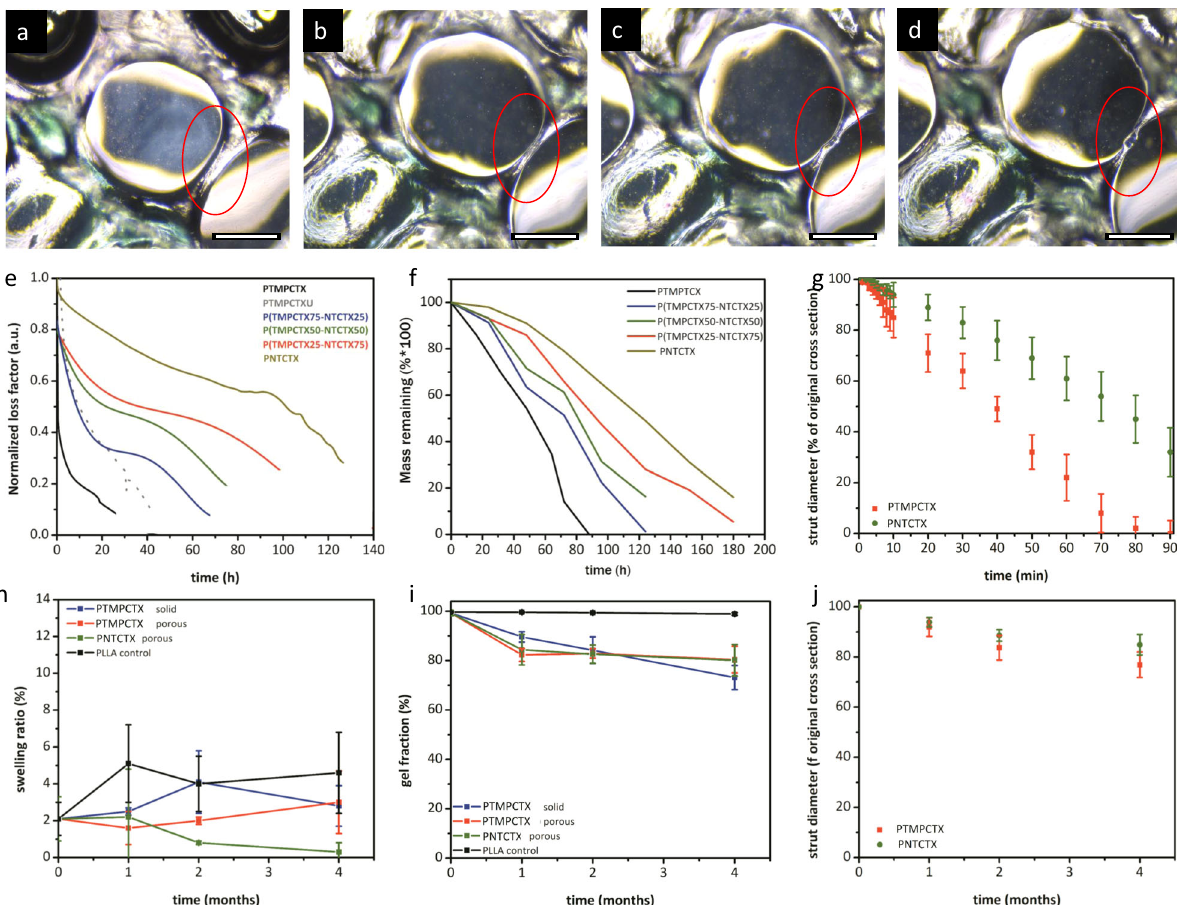
Fig. 6 Swelling and degradation behavior of 3D-printed materials. Representative microscopy images of a printed PTMPTCX scaffold immersed in 5 M NaOH over 15 min, demonstrating surface-erosion behavior of the denoted strut (red circle) immediately upon immersion in the solution ( a ), at 5 min ( b ), 10 min ( c ), and 15 min ( d ). Representative curves of uniaxial testing of polycarbonate-derived material fi lms immersed in 5 M hydrolytic degradation solution at 37 °C, with samples deformed 50 µ m at 1 Hz until failure ( e ) and corresponding static gravimetric degradation analysis at the same conditions ( f ), along with in vitro strut erosion measurements from microscopic analysis of printed scaffolds immersed in 5 M NaOH at 37 °C ( g ). Post-implantation assessment of sample swelling ( h ) and gel fraction ( i ) were used to assess the extent and type of degradation of the samples after removal from tissue at discrete timepoints, with accompanying measurements of strut diameters from printed scaffolds ex vivo ( j ). Scale bar = 200 µ m. Data are presented as mean values with error bars = standard deviation ( n =